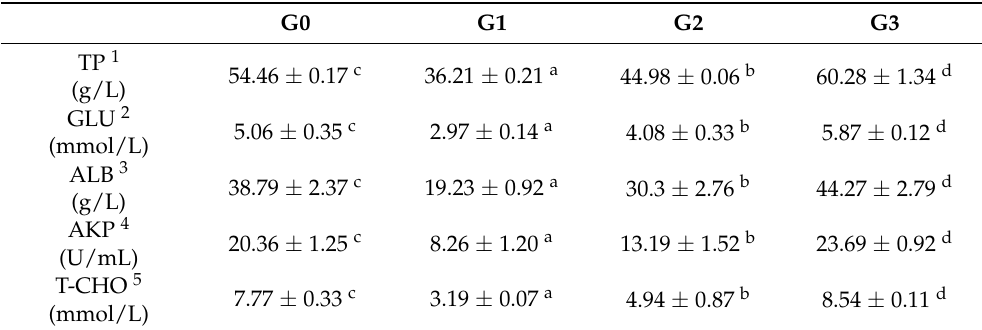
Table 5. Effect of fish meal replaced by unfermented and/or fermented soybean meal on serum physiological and biochemical indices of the juvenile coho